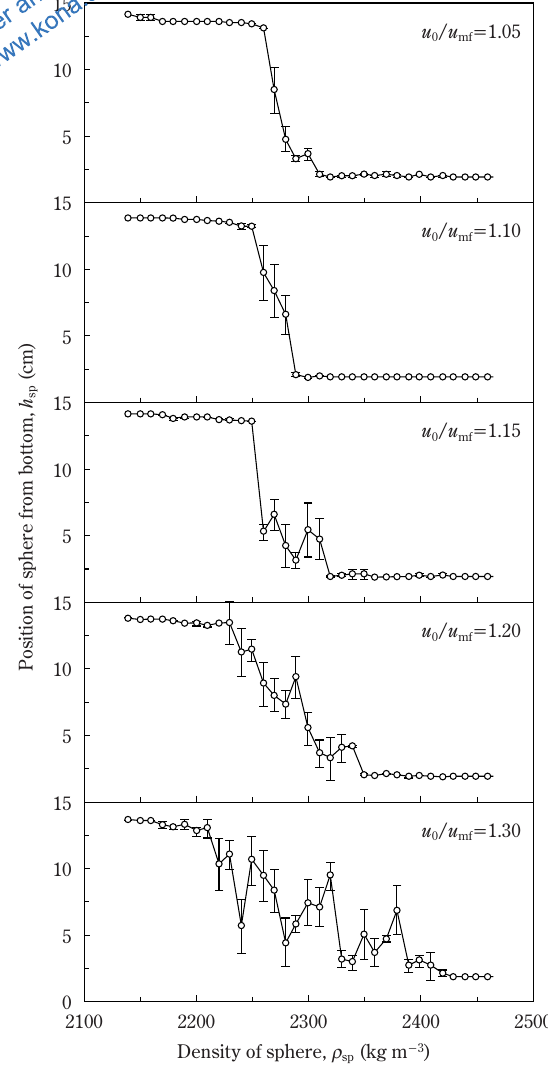
Fig. 4 Dependence of sphere height on density at various superfi- cial velocities. Powder is uni-beads.